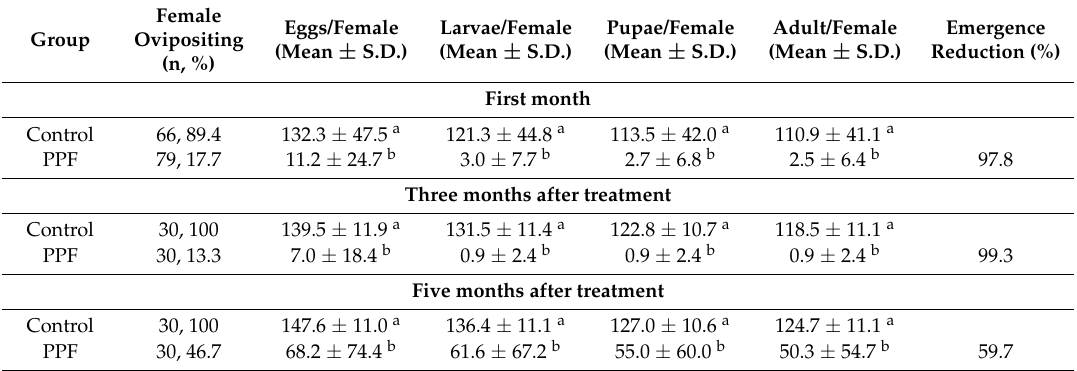
Different letters (a, b, c) in the same columns between the control and PPF groups indicates statistical differences ( p <